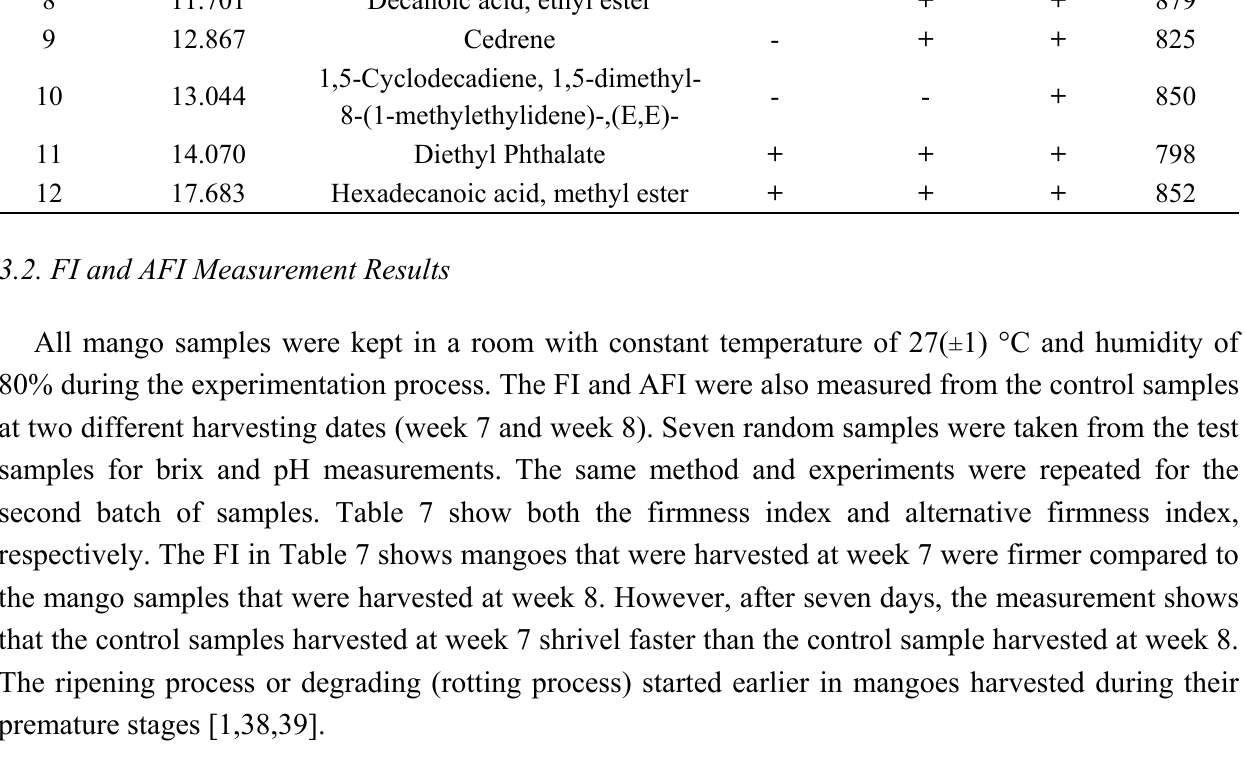
Table 7. FI and AFI for four different maturity and ripeness levels of Harumanis harvested on two different